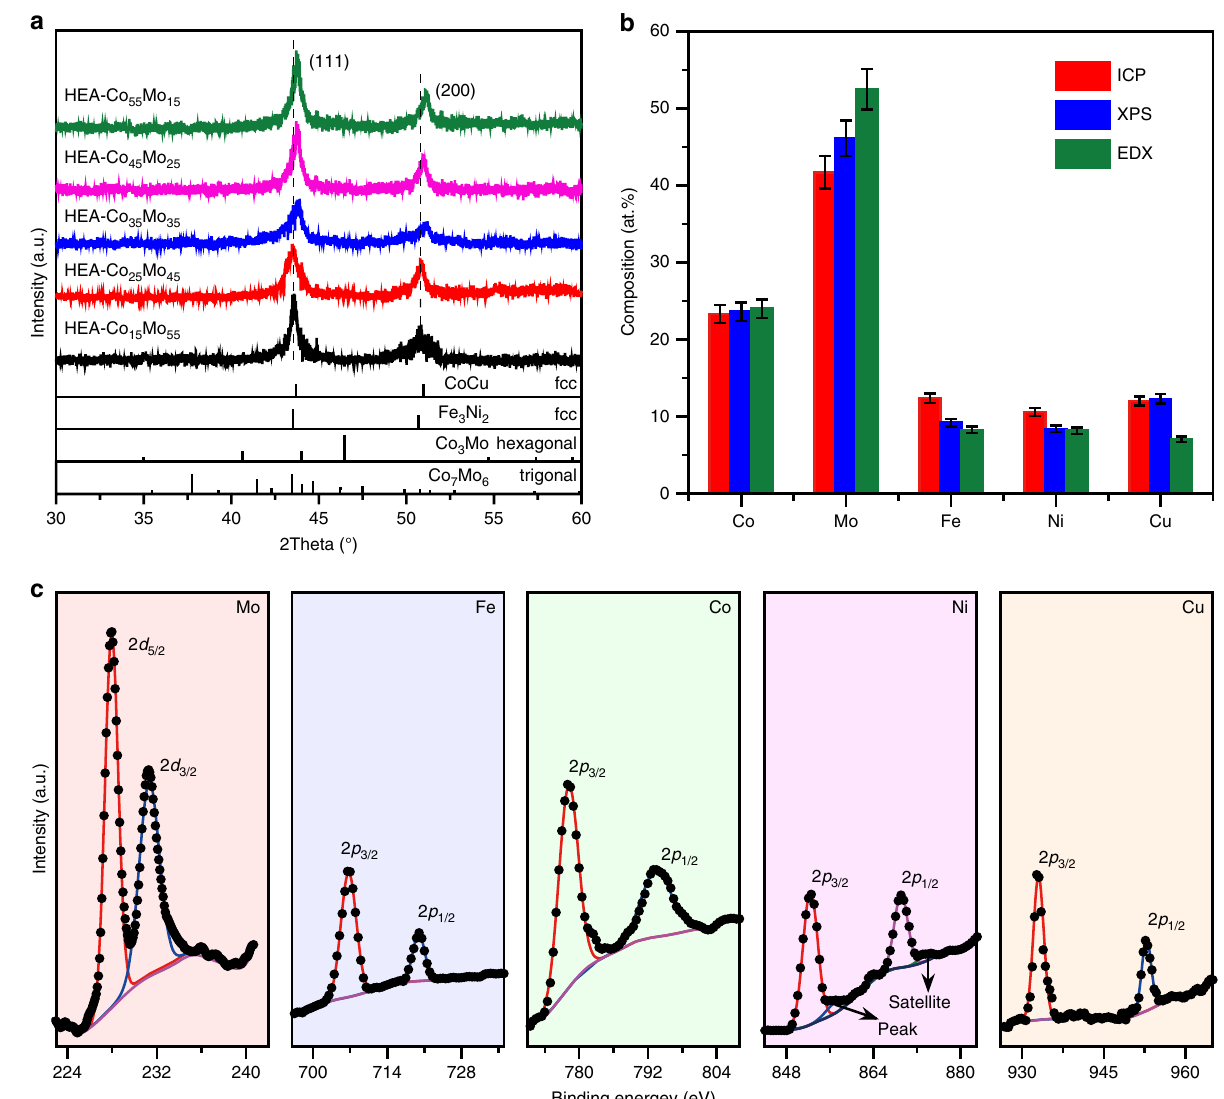
Fig. 3 Characterization of the HEA-Co x Mo y nanoparticles. a XRD patterns of the HEA nanoparticles supported on CNFs in comparison to the bimetallic standards of CoCu (PDF# 50 – 1452), Fe 3 Ni 2 alloy (PDF# 65 – 5131), Co 3 Mo (JCDPS no. 29 – 0488), and Co 7 Mo 6 (JCDPS no. 29 – 0489). b Comparison of the composition analyses for the HEA-Co 25 Mo 45 nanoparticles based on three different techniques: ICP-MS, XPS, and EDX, verifying the alloy homogeneity in